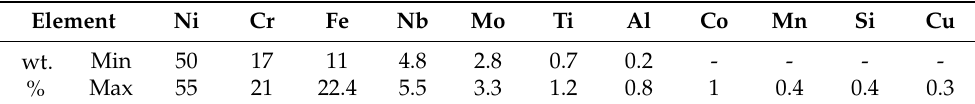
Table 1. Composition of Inconel 718.